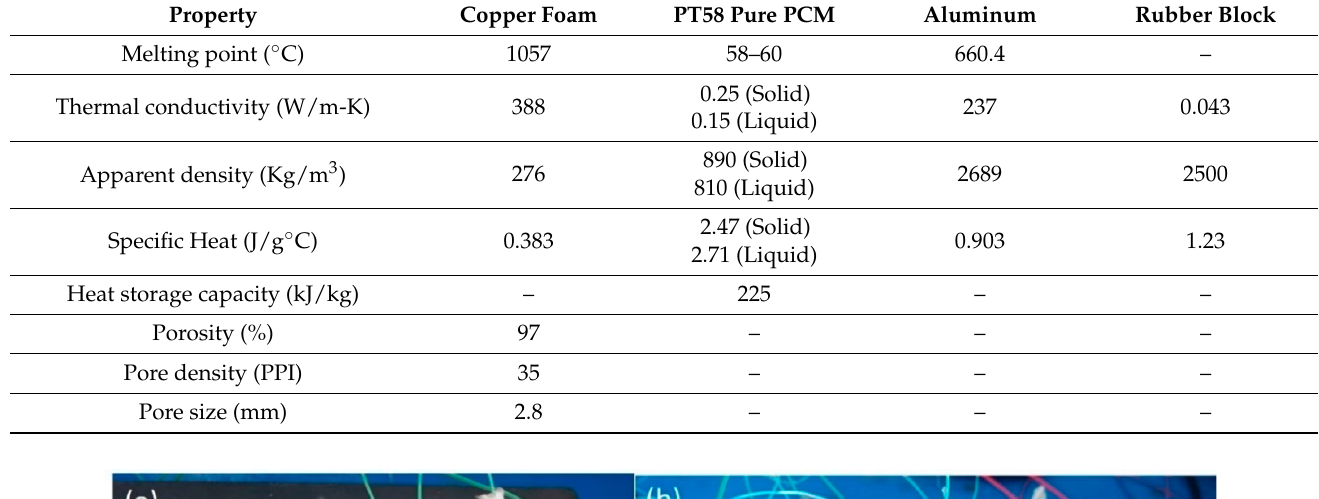
Table 1. Thermophysical Properties of copper foam, PCM and heat sink material [14,25,26].